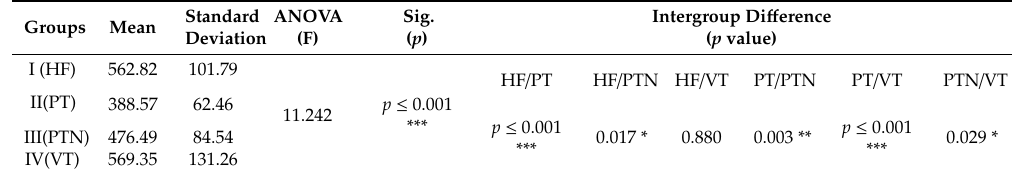
Table 1. Comparison of mean load (Newton) among di ff erent